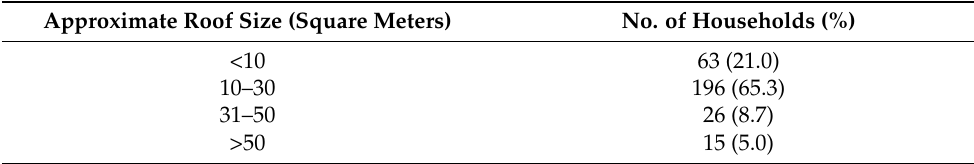
Table 4. Approximate size of the roof catchment area for rainwater